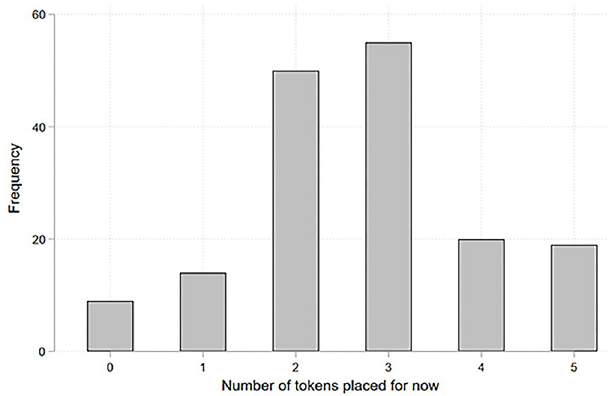
Fig 2. Distribution of the number of tokens placed for “now” (N =